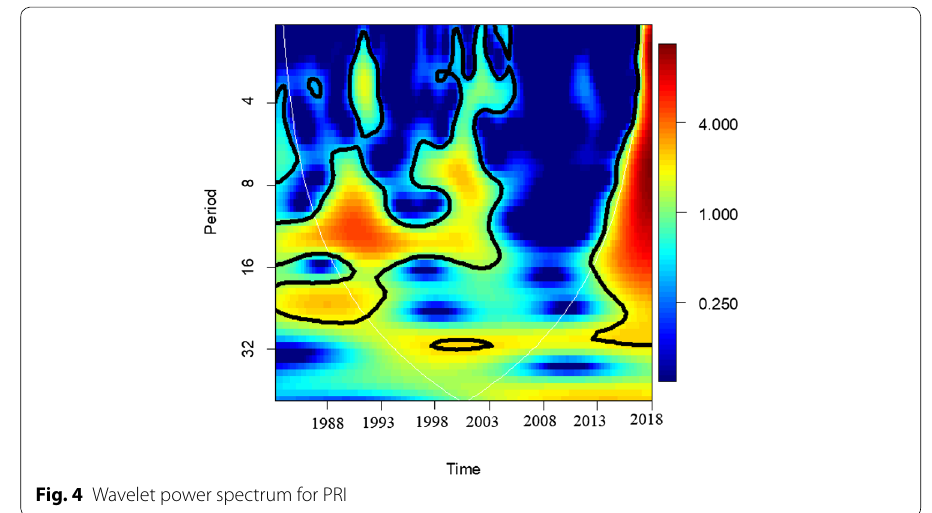
Fig. 4 Wavelet power spectrum for PRI